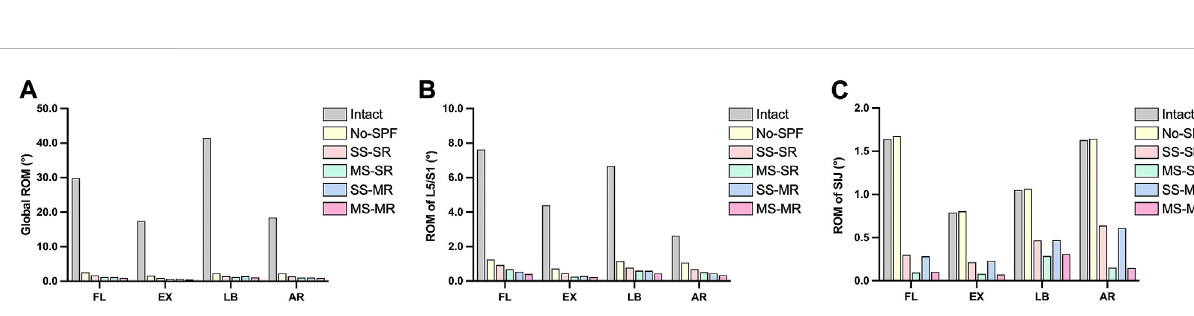
FIGURE 4 Comparison of the range of motion among intact and instrumented models. (A) the global range of motion; (B) the range of motion of lumbosacral junction; (C) the range of motion of sacroiliac